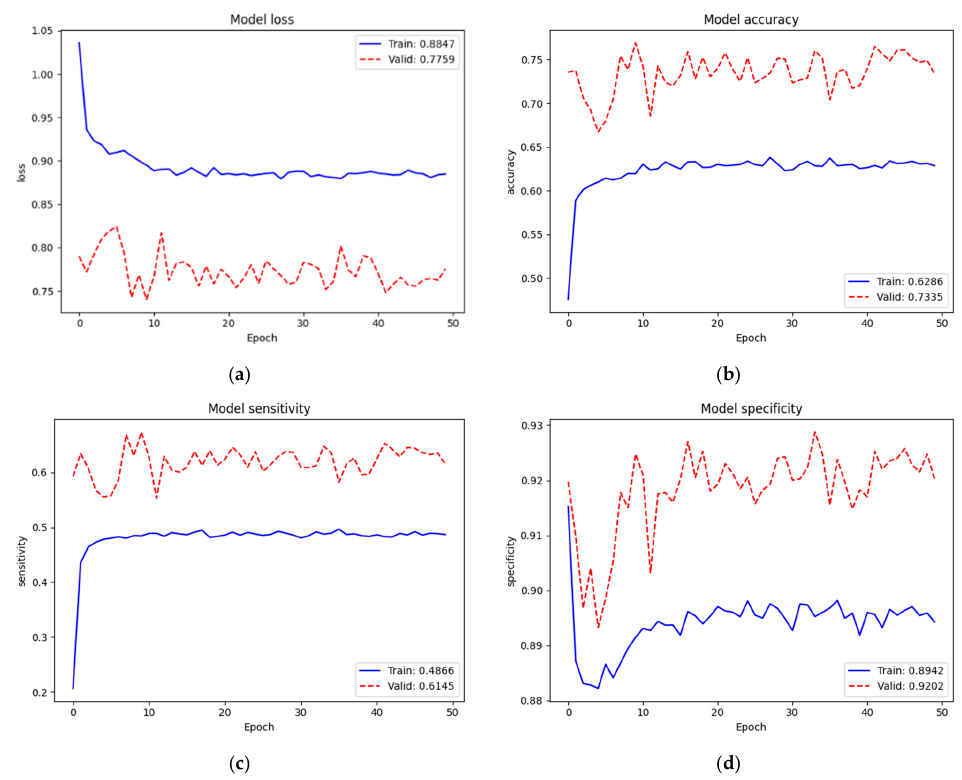
Figure 6. Train and validation performances of the NIH data set on new top layers: ( a ) loss; ( b ) accuracy; ( c ) sensitivity; ( d ) specificity. To identify the three classes of lung diseases, the validation performance ( 𝐿𝑜𝑠𝑠 = 0.7759, 𝐴𝑐𝑐 = 73.35%, 𝑆𝑒𝑛 = 61.45%, and 𝑆𝑝𝑒 = 92.02%) of only the new top layers was not so bad but also not yet acceptable. Therefore, we re-trained (second train) on the com- plete model. Figure 7 depicts the training and validation performances of the NIH data set on the complete model. The loss, accuracy, sensitivity, and specificity of training were 0.4597, 90.59%, 89.18%, and 96.27%, respectively. Since we trained on the complete model excluding batch normalization layers (52,862,199 parameters) from the pre-trained weights of ImageNet and our recently trained new top layers, the train performance was improved. The validation performance ( 𝐿𝑜𝑠𝑠 = 0.6933, 𝐴𝑐𝑐 = 82.15%, 𝑆𝑒𝑛 = 81.40%, and 𝑆𝑝𝑒 = 91.65%) was also improved. In this training, we noticed that the dropout mechanism did not cause a validation performance higher than the training one, which expressed that it was trained and fit the model well. Additionally, we noticed that the loss started to converge after epoch 15. Thus, we assumed that 25 epochs were enough for this training.